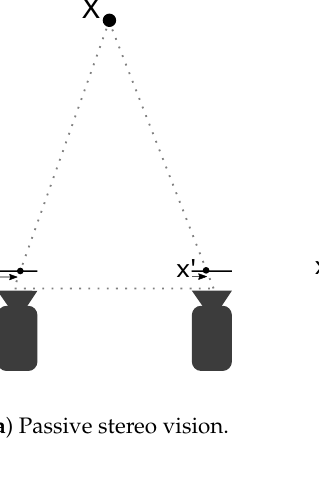
Figure 2. Different variations of depth sensing